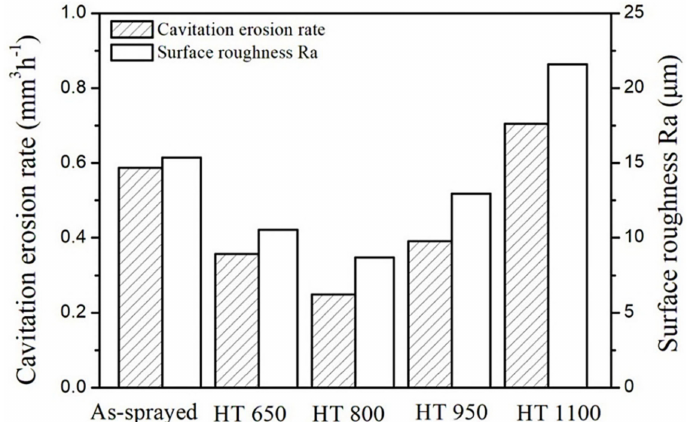
Figure 12. Cavitation erosion rate and surface roughness R a of as-sprayed and heat-treated